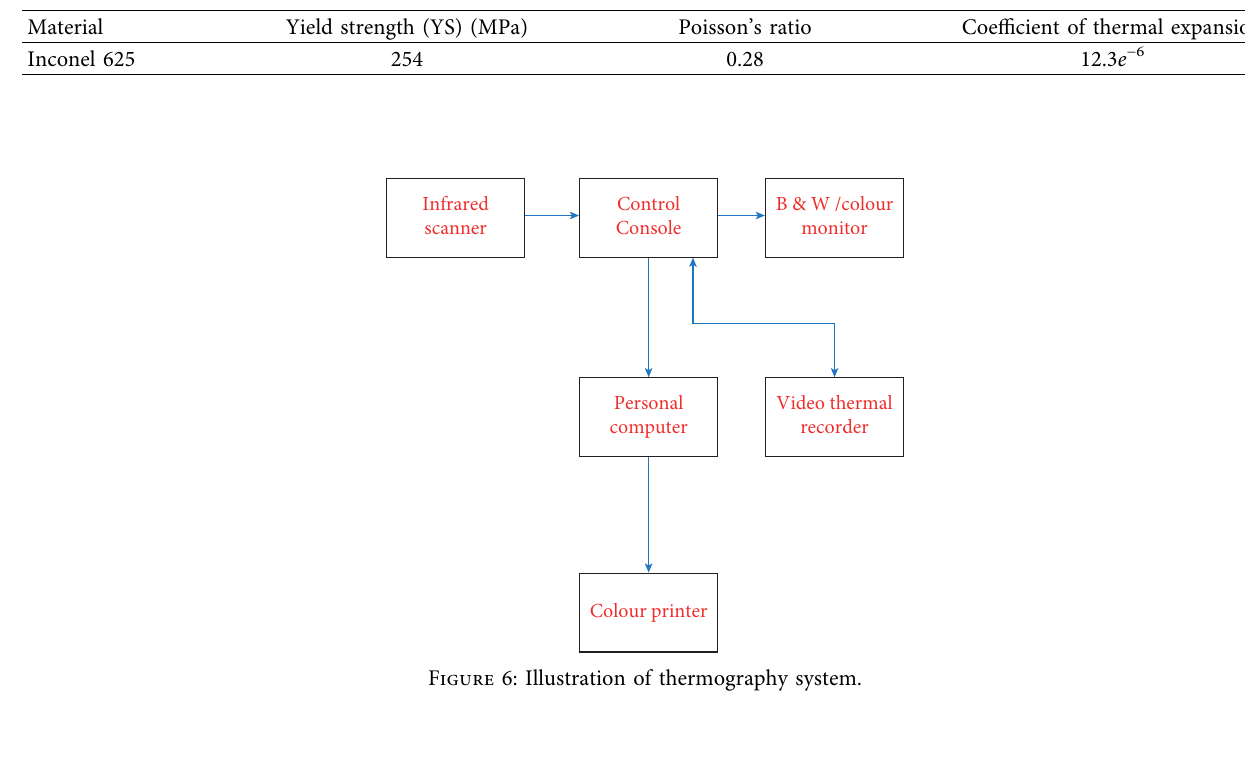
Table 3: Parent material mechanical properties.